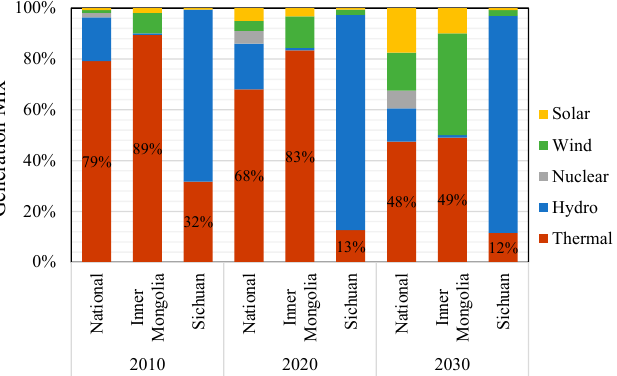
Figure 3. Electricity generation mix in China and two regions in 2010, 2020 and 2030.